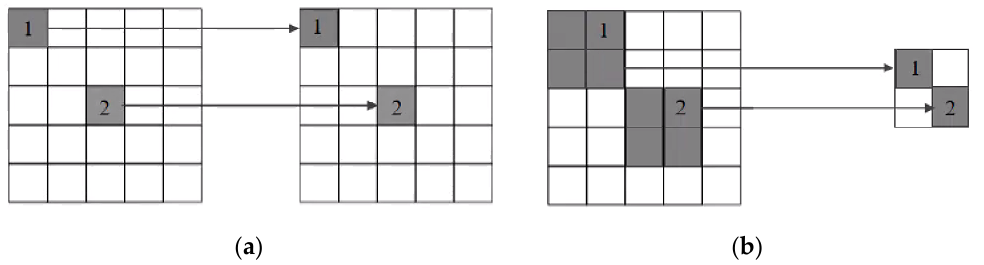
Figure 4. ( a ) Pixel-based algorithm operation (interferometry and differential interferometry). ( b ) Window-based algorithm operation (multilook filtering).